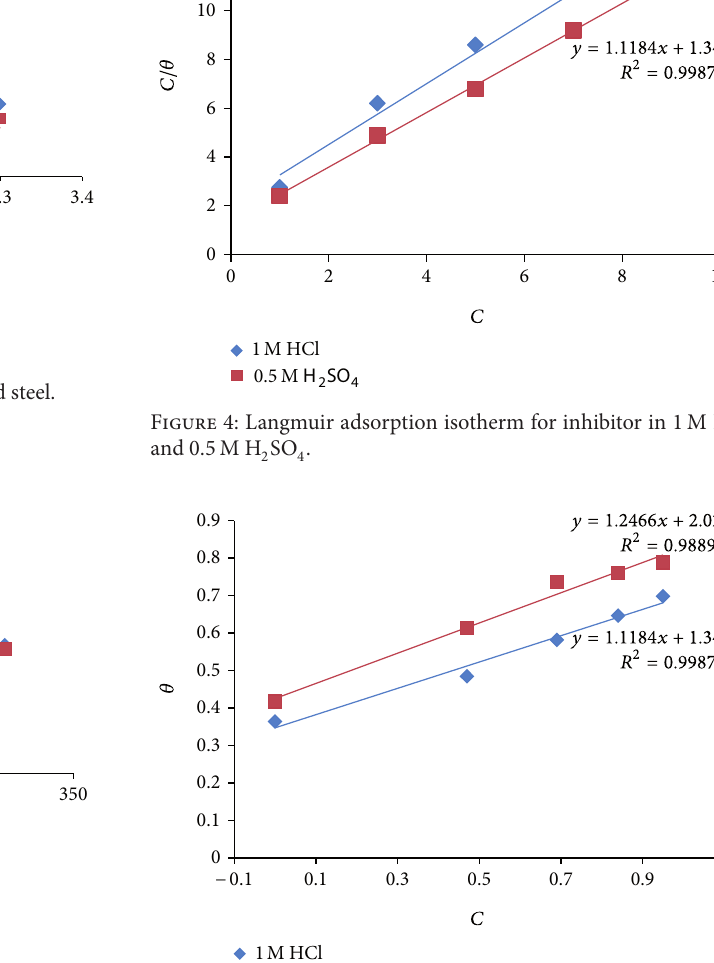
F 3: Free energy of adsorption of SPAH in in 1M HCl and 0.5M H